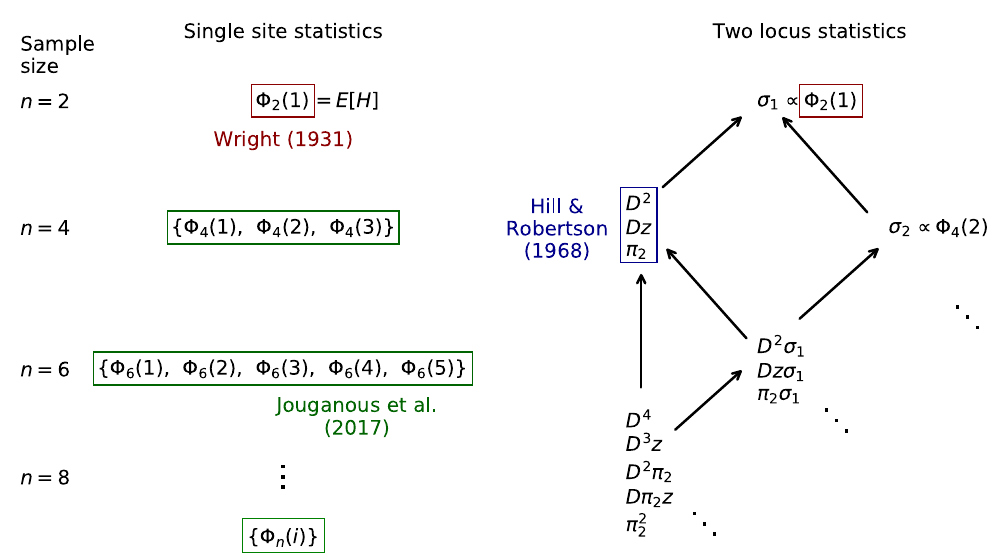
Fig 1. Hierarchy of even-order moments of Wright-Fisher evolution. Expected statistics under neutral Wright-Fisher evolution depend on equal or lower-order statistics in the previous generation, allowing for a hierarchy of closed recursion equations. Left: single-site statistics are represented as the entries in the size- n AFS, F same-order statistics. Right: the corresponding two-locus statistics, including the Hill-Robertson system for E ½ D 2 � , rely on statistics of the same or lower order. Closed recursions can be found for any given E ½ D m � , leading to a sparse, linear system of ODEs. We denote